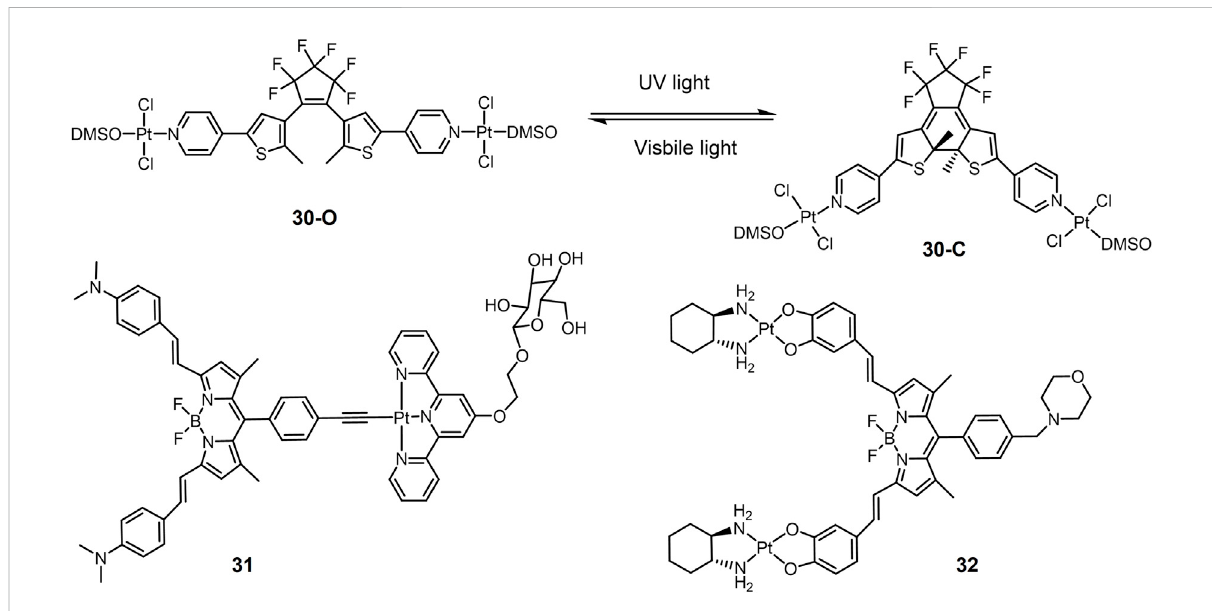
FIGURE 7 Light-responsive Pt(II) prodrugs bearing chromophores for PACT ( 30 ) or PDT ( 31-32